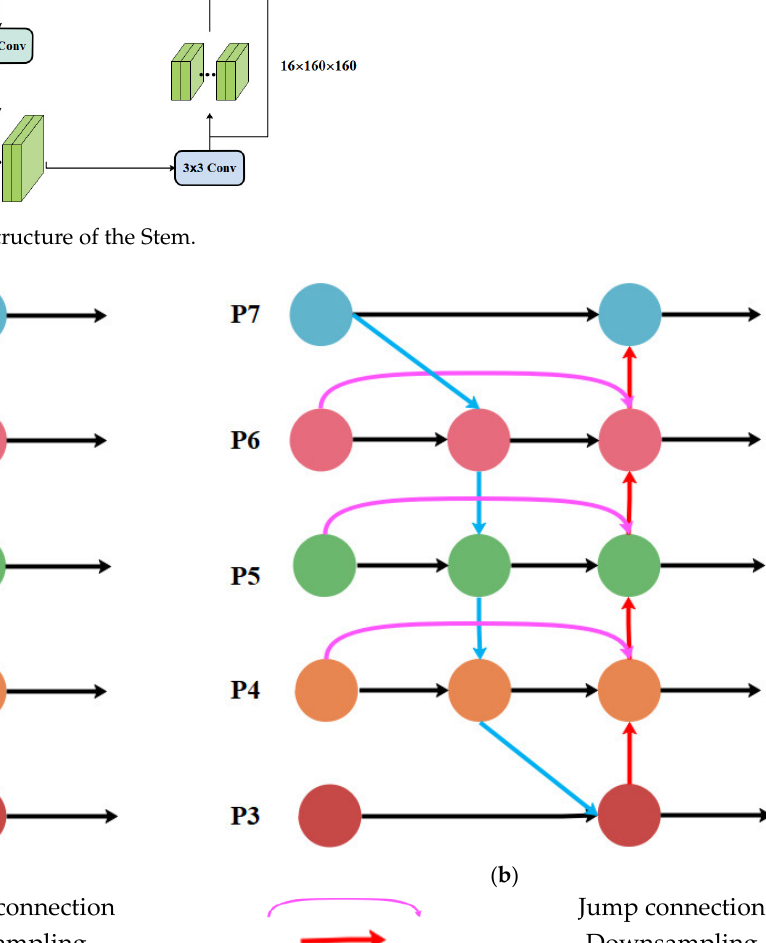
Figure 9. The structure of the improved YOLOv5s model.